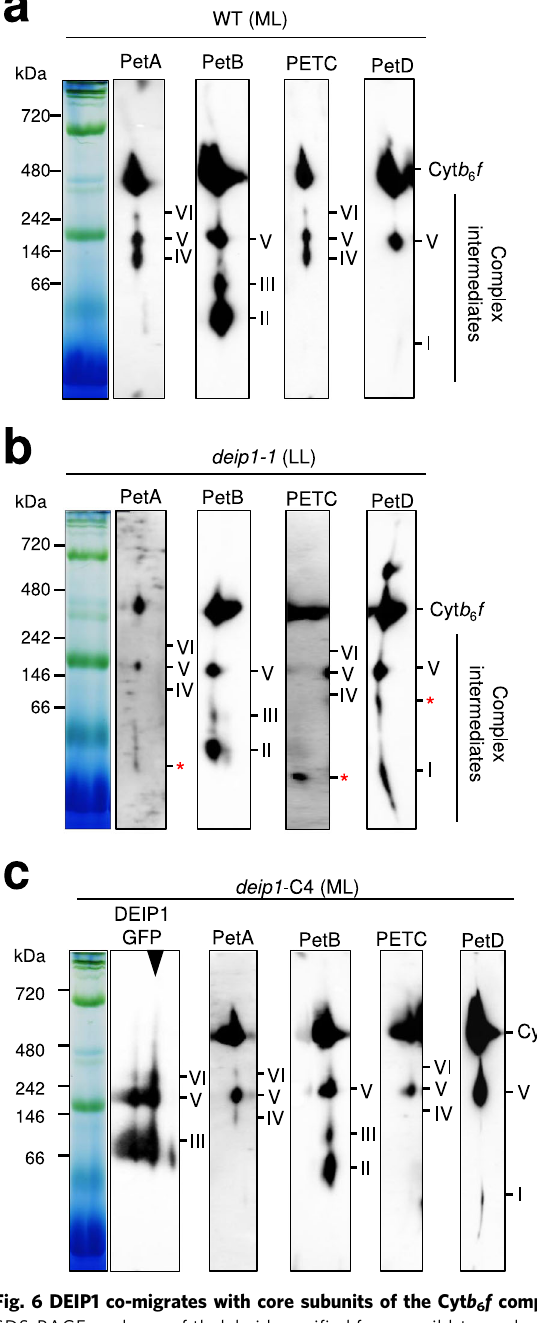
Fig. 6 DEIP1 co-migrates with core subunits of the Cyt b 6 f complex. 2D- SDS-PAGE analyses of thylakoids puri fi ed from a wild-type plants grown under moderate (ML) light for 7 days, b deip1-1 mutants grown under low light (LL) for 5 weeks, and c the deip1 -C4 complemented line grown under moderate light (ML) for 7 days. Thylakoid samples equivalent to 20 µ g chlorophyll were solubilized in β -DDM, and resolved in an 8 – 13.8% gradient gel. SDS-PAGE was performed as second dimension, and immunodetection was conducted with anti-PetA, anti-PetB, anti- PETC, and anti-PetD antibodies. For the deip1 -C4 line, the antibody against GFP was included, and the band that corresponds to DEIP1-GFP is indicated by the black arrowhead. Putative assembly intermediates are indicated as I, II, III, IV, V, and VI. See text for details. n = 3 independent biological